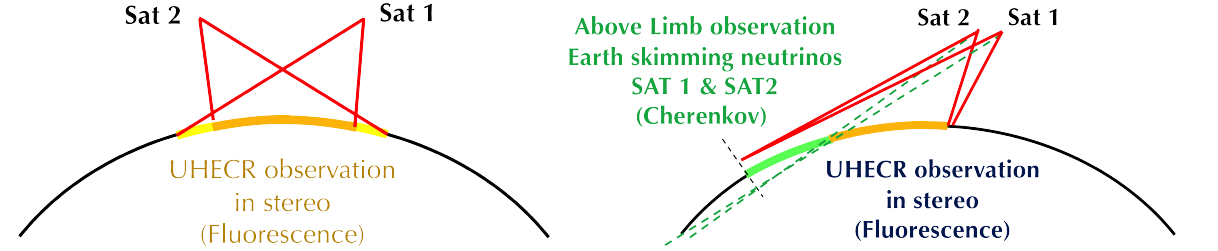
Figure 6. An illustration of POEMMA’s stereo UHECR (left) and neutrino (right) observation modes.